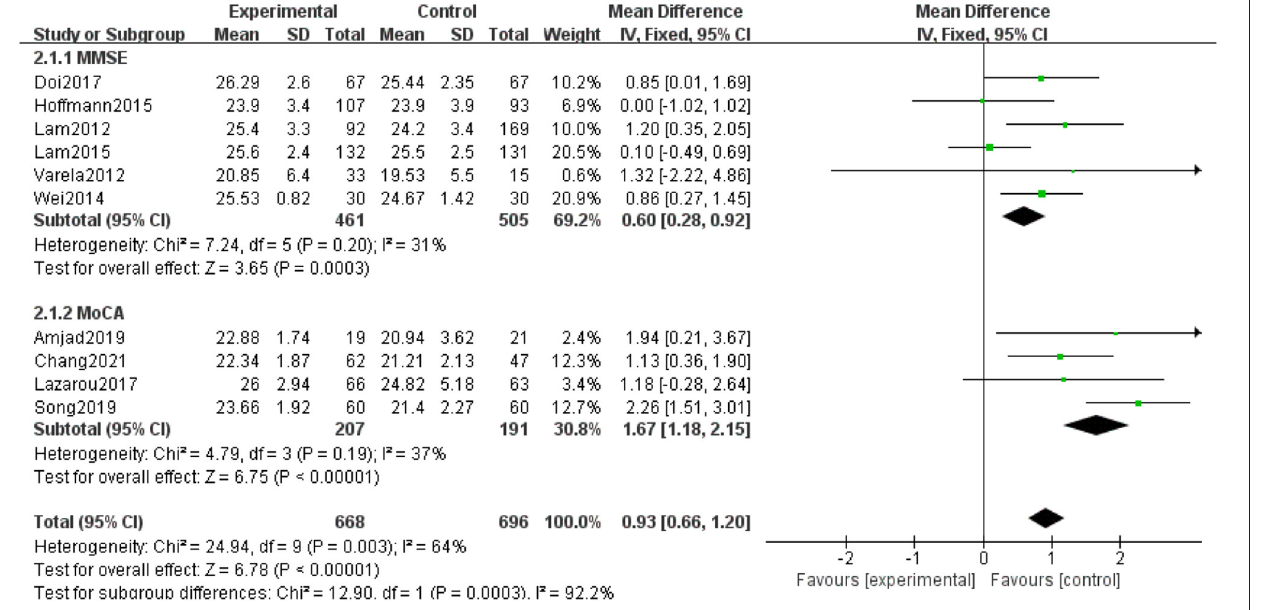
FIGURE 3 | Forest plot for aerobic exercise on global cognition function with MCI older. MMSE, Mini-Mental State Examination; MoCA, Montreal Cognitive